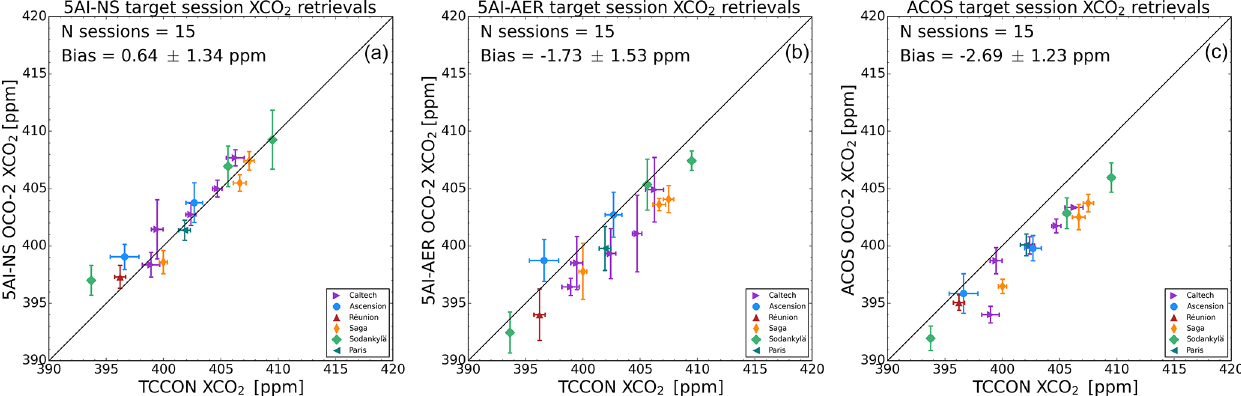
retrieval results compared to the TCCON official X CO 2